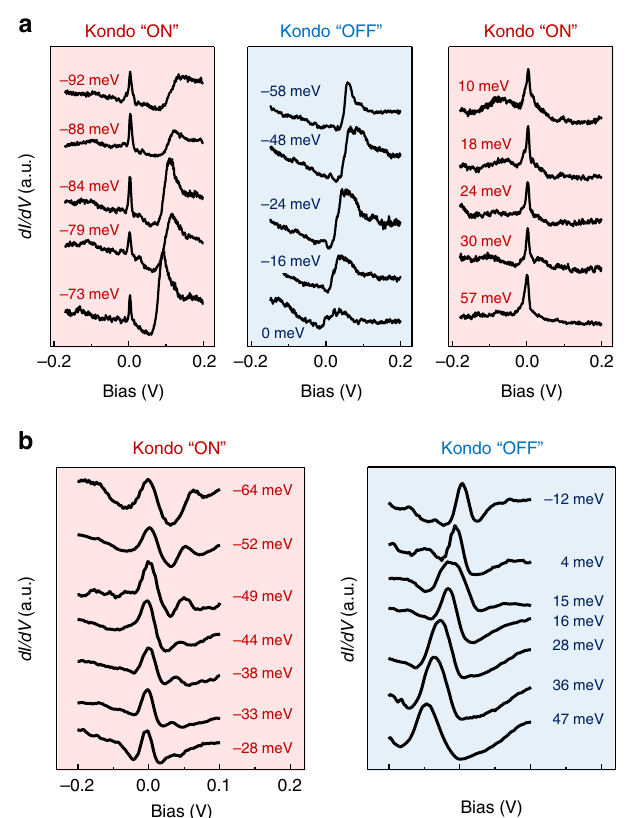
Fig. 2 Evolution of Kondo screening with chemical potential. a dI / dV curves for a subcritical Kondo vacancy (type I in text) with reduced coupling strength Γ 0 / Γ C = 0.90 at the indicated values of chemical potential. Red (blue) shade indicates the presence (absence) of the Kondo peak ( V b = − 200mV, I = 20pA). The chemical potential is tuned by the backgate voltage 28 . b dI / dV curves for a supercritical Kondo vacancy (type II in text) with Γ 0 / Γ C =